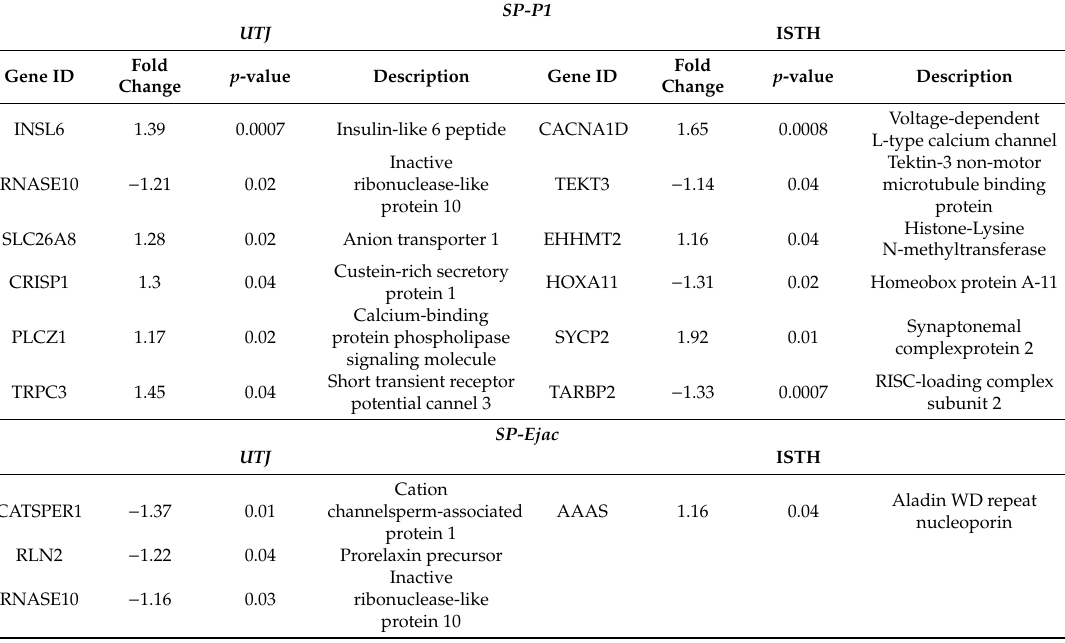
Table 2. Subset of altered transcripts potentially involved in sperm capacitation and / or fertilization in UTJ and Isth segments of the oviduct 24 h after sperm-free seminal plasma (SP) exposal (SP-P1 or